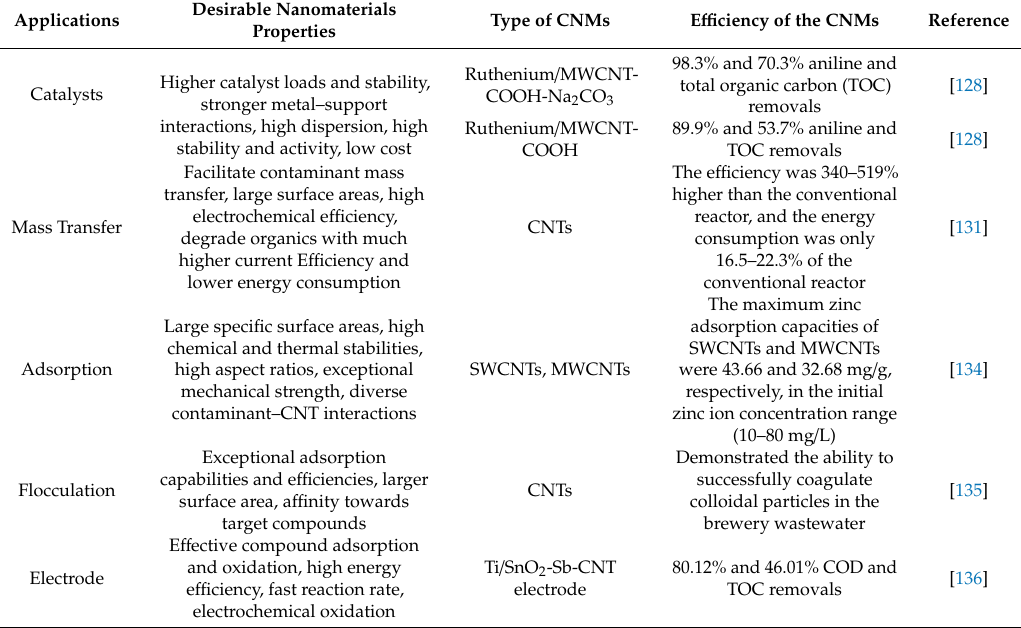
Figure 8. Schematic diagram representing different modification processes of CNTs for contaminant removal from water and wastewater (C: carbon; CNT: carbon nanotube; ENVT: environmental; Hg: mercury; KOH: potassium hydroxide) [129]. Table 7. Applications of CNMs in wastewater treatment. COD, chemical oxygen